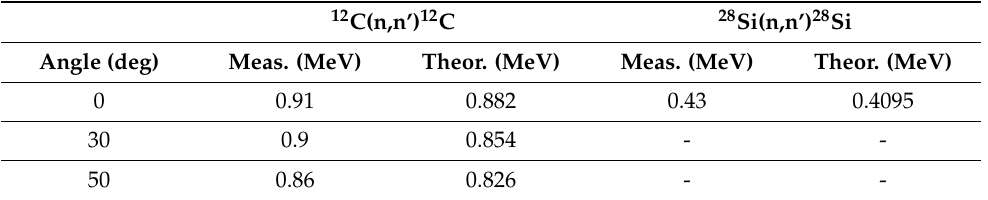
Table 2. Expected and measured positions of the elastic edges for both 12 C and 28 Si for the three